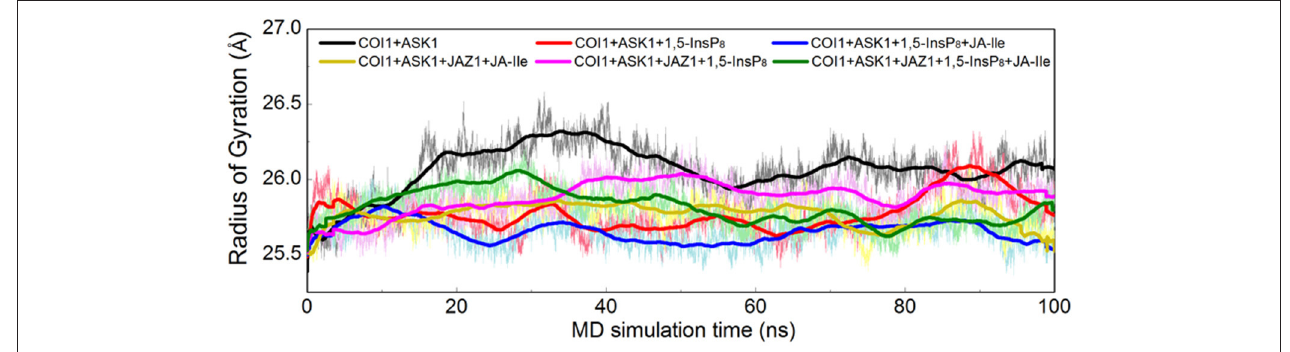
FIGURE 4 | Rg plots of backbone atoms of protein for the six systems. Black is used for system 1 (COI1 + ASK1), red for system 2 (COI1 + ASK1 + 1,5-InsP 8 ), blue for system 3 (COI1 + ASK1 + 1,5-InsP 8 + JA-Ile), yellow for system 4 (COI1 + ASK1 + JAZ1 + JA-Ile), magenta for system 5 (COI1 + ASK1 + JAZ1 + 1,5-InsP 8 ), and green for system 6 (COI1 + ASK1 + JAZ1 + 1,5-InsP 8 +